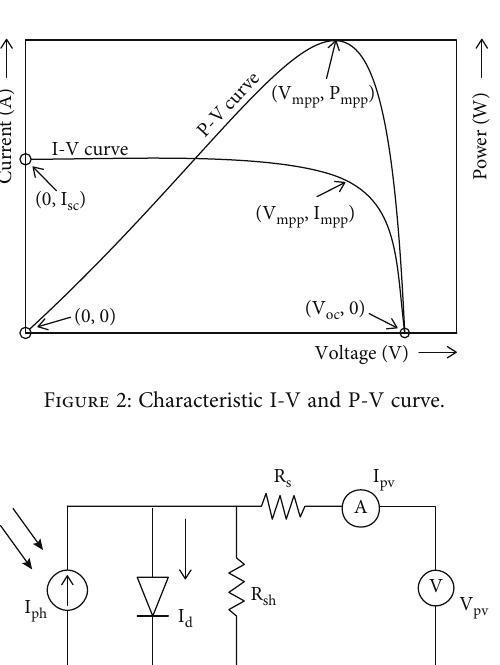
Figure 1: Circuit of equivalence – ideal SPV cell.